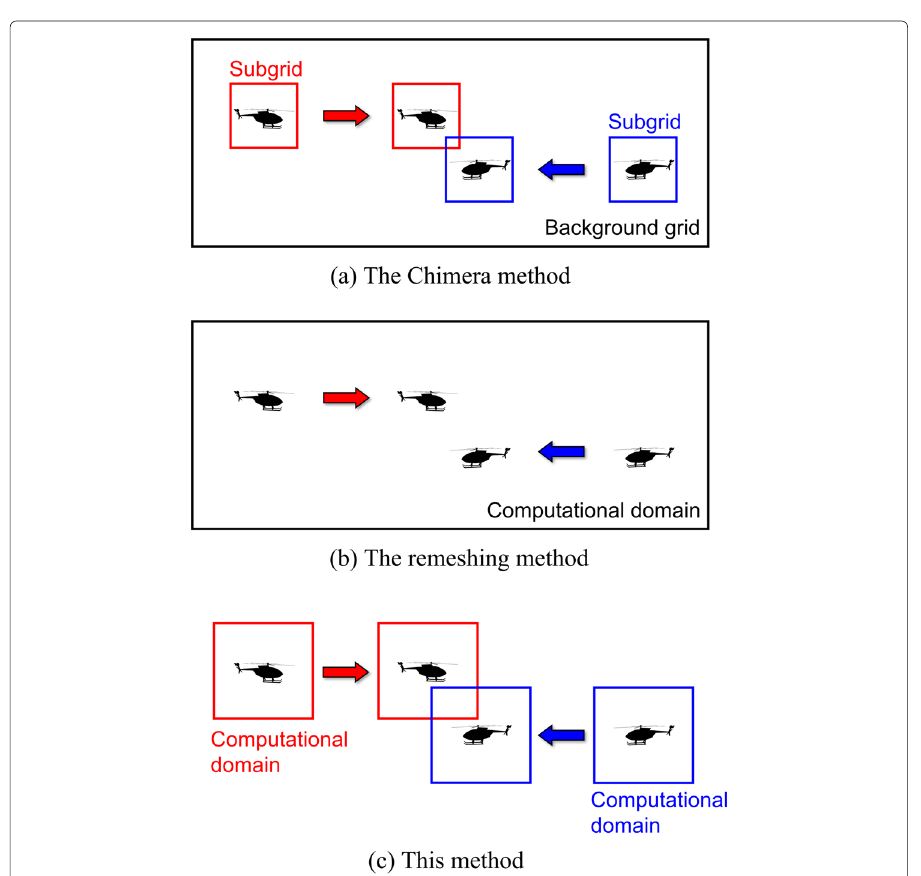
Fig. 1 The concept of ( a ) the Chimera method, ( b ) the remeshing method, and ( c ) this method (illustrated in two-dimensions)